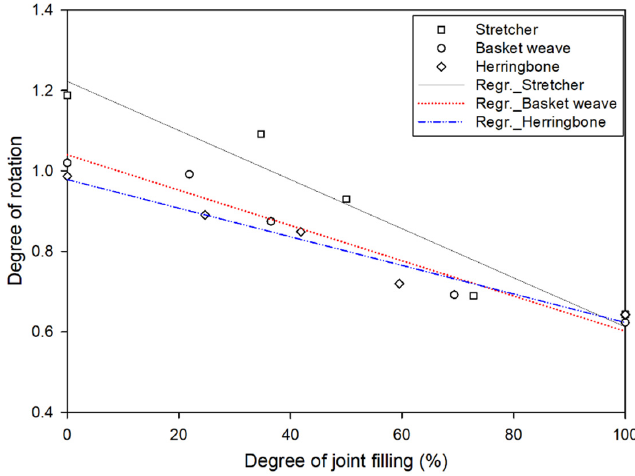
Figure 11. Rotational angles according to lying pattern and degree of joint filling.